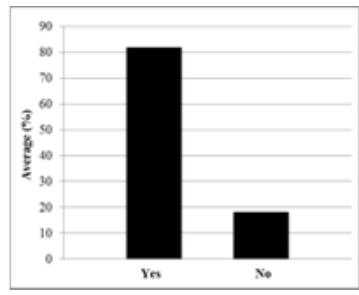
Figure 12. Responses from the Titration experimental group on whether they would suggest LabLessons to a